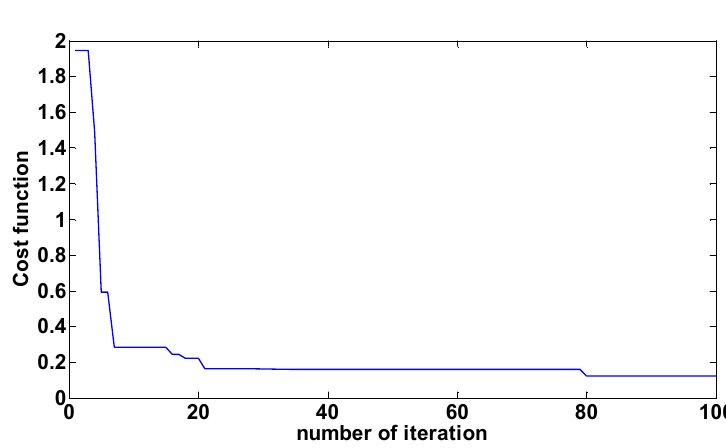
Figure 5. Convergence curve.